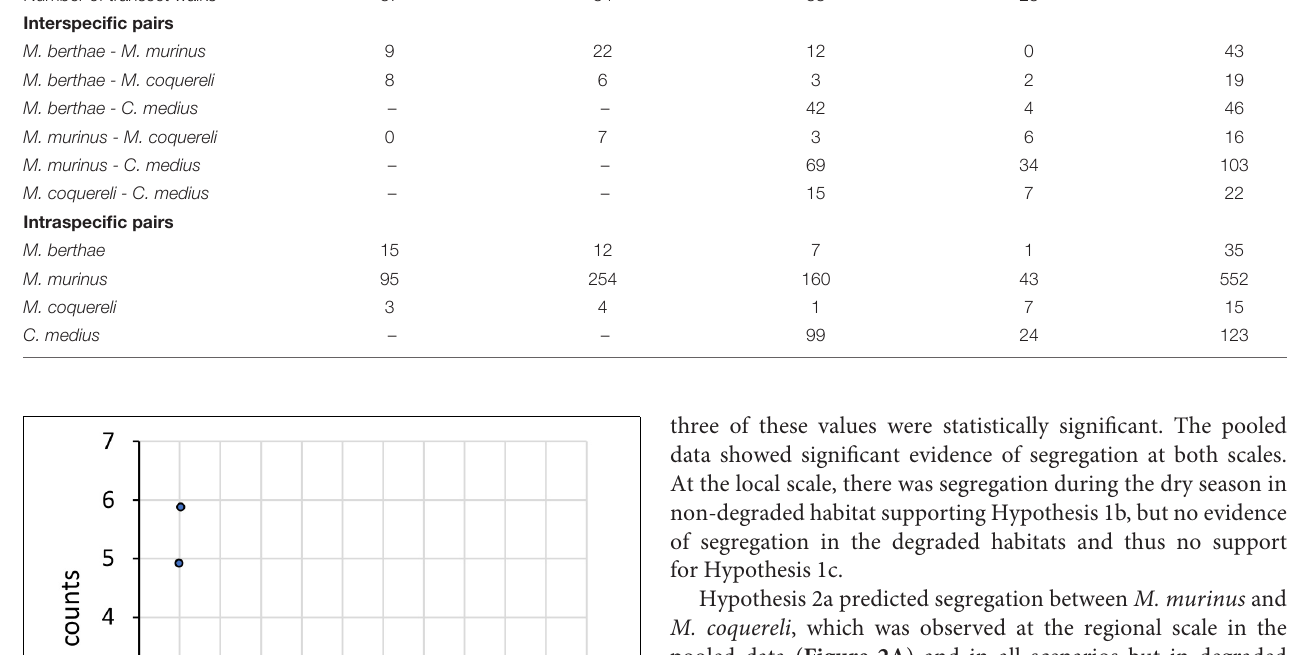
TABLE 3 | Number of transect walks per scenario as well as the numbers of inter- and intraspecific pairs of individuals detected within 150 m on single transect walks.